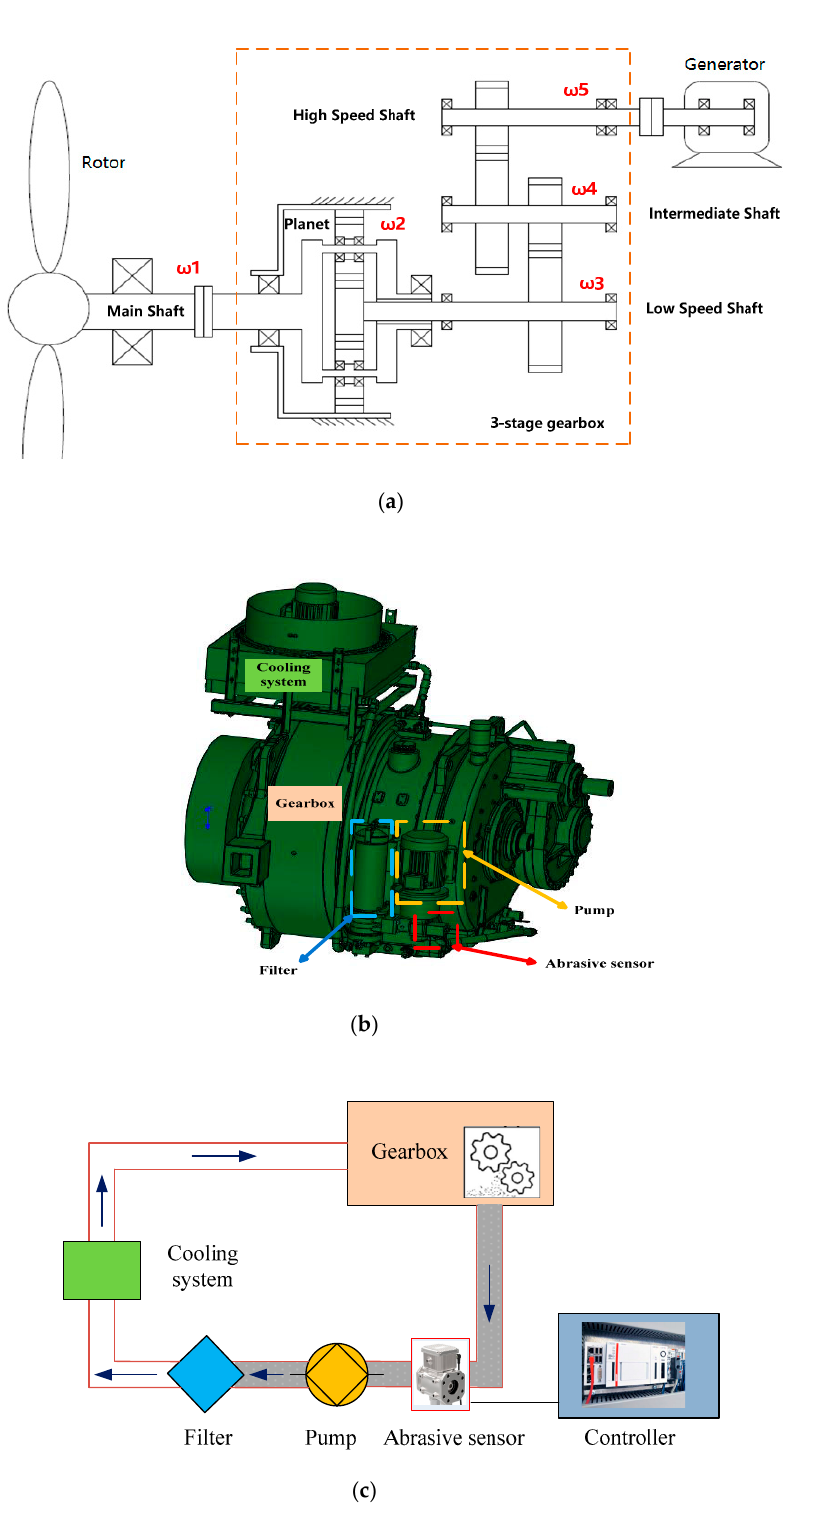
Figure 11. The wind turbine drivetrain and installation position of the abrasive particle sensor. ( a ) The test wind turbine drivetrain and 3-stage gearbox layout. ( b ) The sensor installation location model. ( c ) The abrasive sensor installation position diagram.